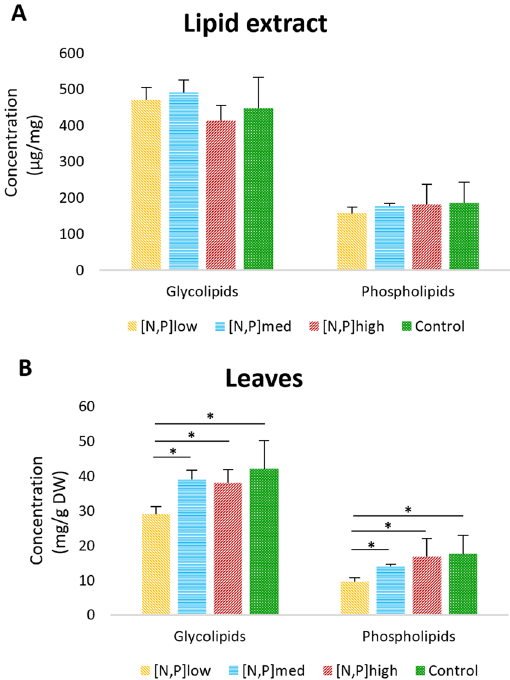
Figure 2. Glycolipids and phospholipids concentrations in ( A ) leaves lipid extract and in ( B ) leaves dry mass of Halimione portulacoides . Error bars represent standard deviations and horizontal lines with symbol * represent significant differences: * p < 0,05; ** p <